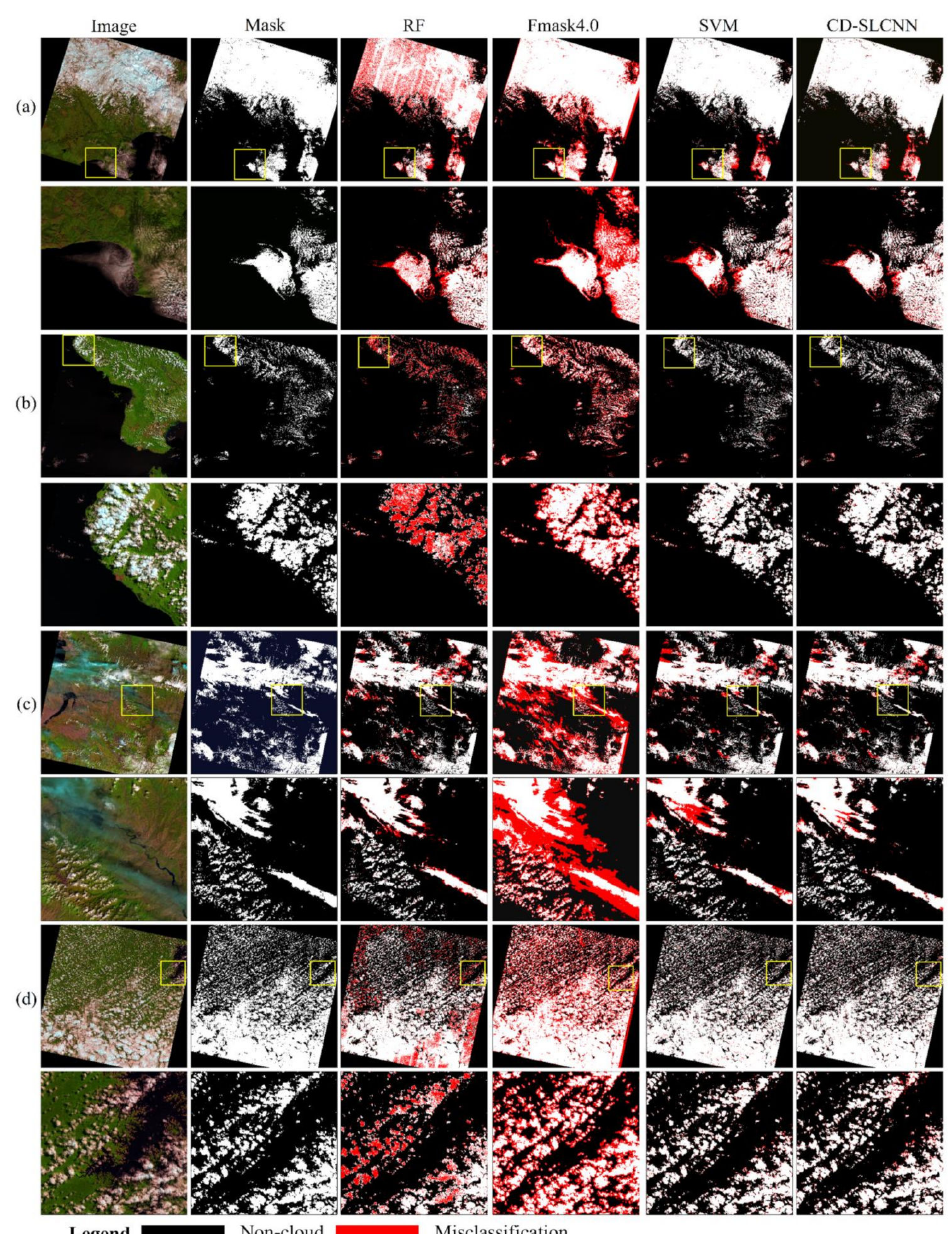
Figure 8. Comparison of the Mask, RF, Fmask4.0, SVM, and CD-SLCNN cloud detection results on Landsat-8 biome for: ( a ) forest and ocean areas, acquired on 26 August 2014, with a center longitude at 149 ◦ E and a center latitude at 60 ◦ N, at Path 108 and Row 18; ( b ) urban and ocean areas, acquired on 29 August 2014, with a center longitude at 121 ◦ E and a center latitude at 4 ◦ S, at Path 113 and Row 63; ( c ) cultivated land areas, acquired on 31 August 2013, with a center longitude at 101 ◦ E and a center latitude at 36 ◦ N, at Path 132 and Row 35; ( d ) forest and inland water areas, acquired on 21 May 2014, with a center longitude at 56 ◦ W and a center latitude at 4 ◦ N, at Path 229 and Row